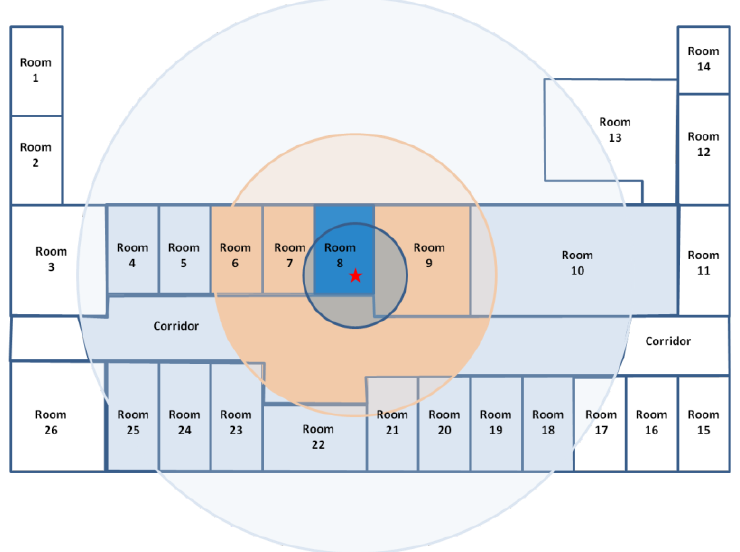
Figure 1. Philosophy of the symbolic positioning.